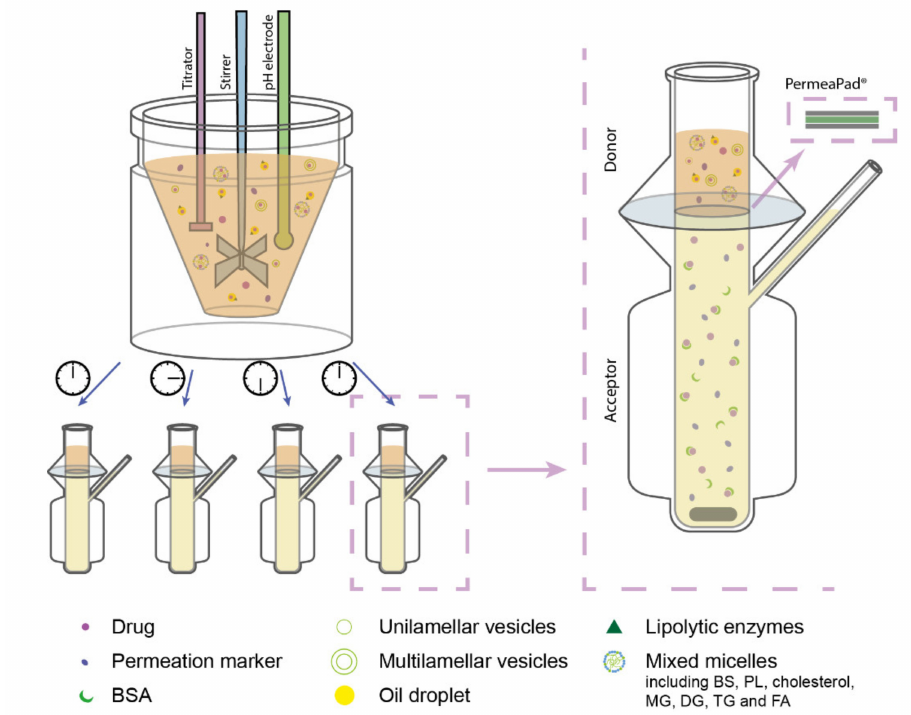
Figure 1. Schematic illustration of the designed lipolysis-permeation method: in vitro lipolysis of an SNEDDS was coupled with permeation across a PermeaPad ® barrier in Franz diffusion cells with PBS BSA in the acceptor compartment. Each lipolysis sample contained lipolysis products of the lipid-based drug delivery system (LbDDS) and the permeation marker (calcein) which was embedded in the simulated intestinal medium. Abbreviations: BS, bile salt; BSA, bovine serum albumin; DG, diglycerides; FA, fatty acids; MG, monoglycerides; PBS BSA , phosphate-buffered saline (pH 7.4) with 4% ( w / v ) BSA; PL, phospholipids; TG,